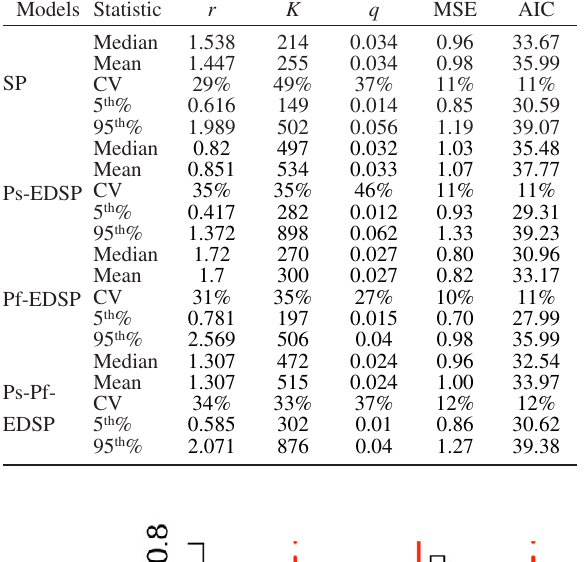
Table 6. – Summary of the estimates of parameters with the boot- strapped ML method from 1500 runs of bootstrap simulation for CPUE and catch data observed from 2003 to 2012 for D. gigas . For each bootstrap run, mean square error (MSE) was calculated. Models Statistic